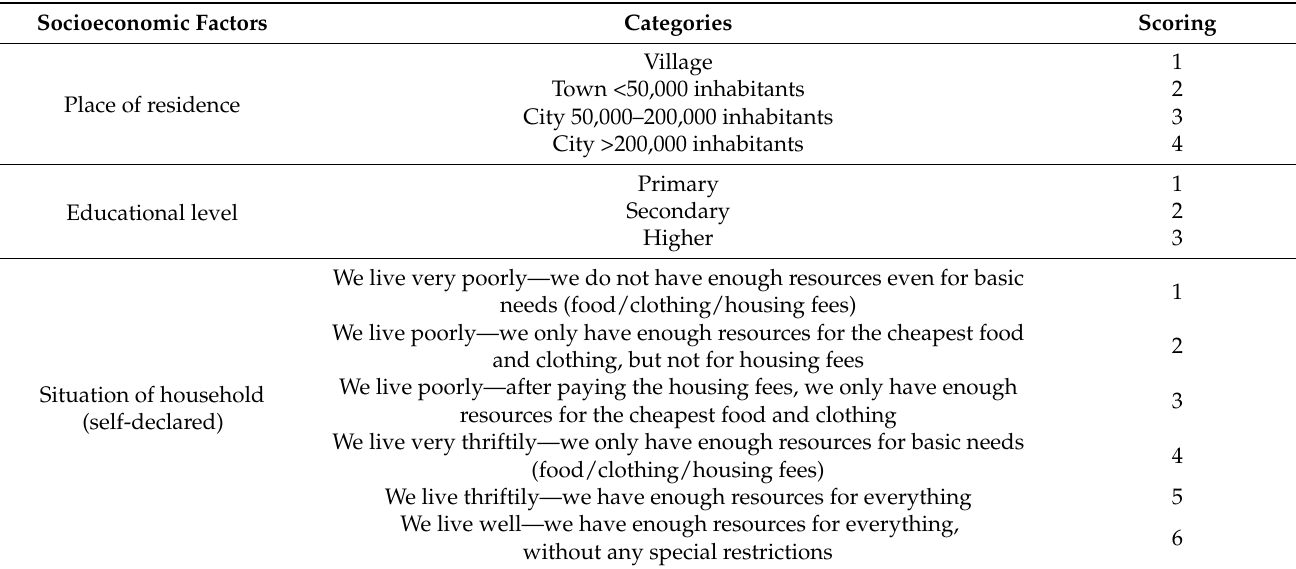
Table 1. Description of the socioeconomic status